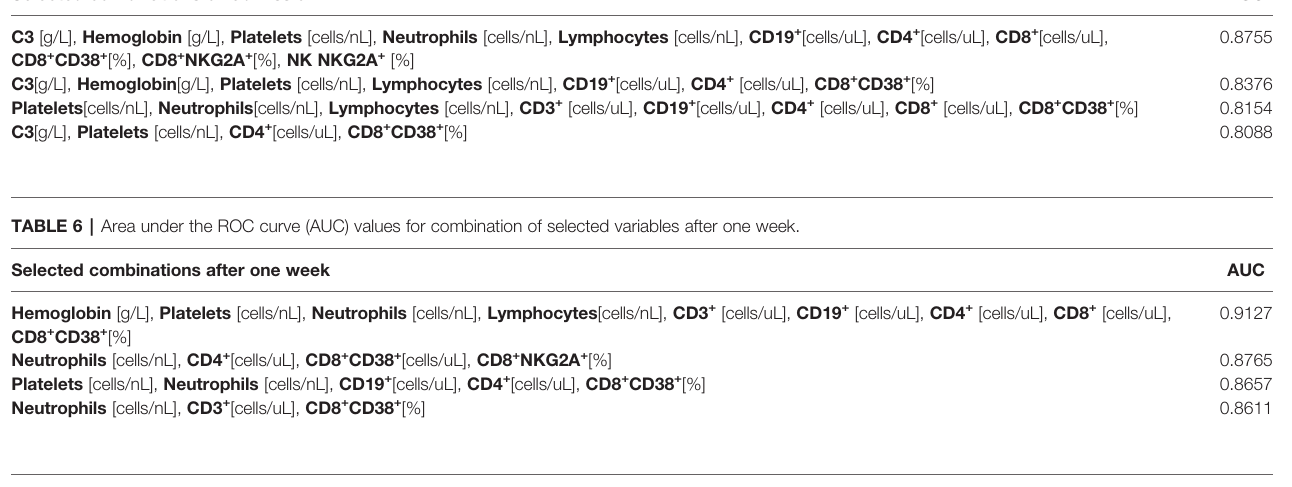
TABLE 5 | Area under the ROC curve (AUC) values for combination of selected variables on admission. Selected combinations on admission